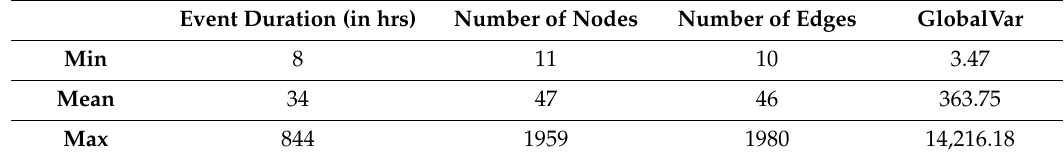
Table 1. Global graph